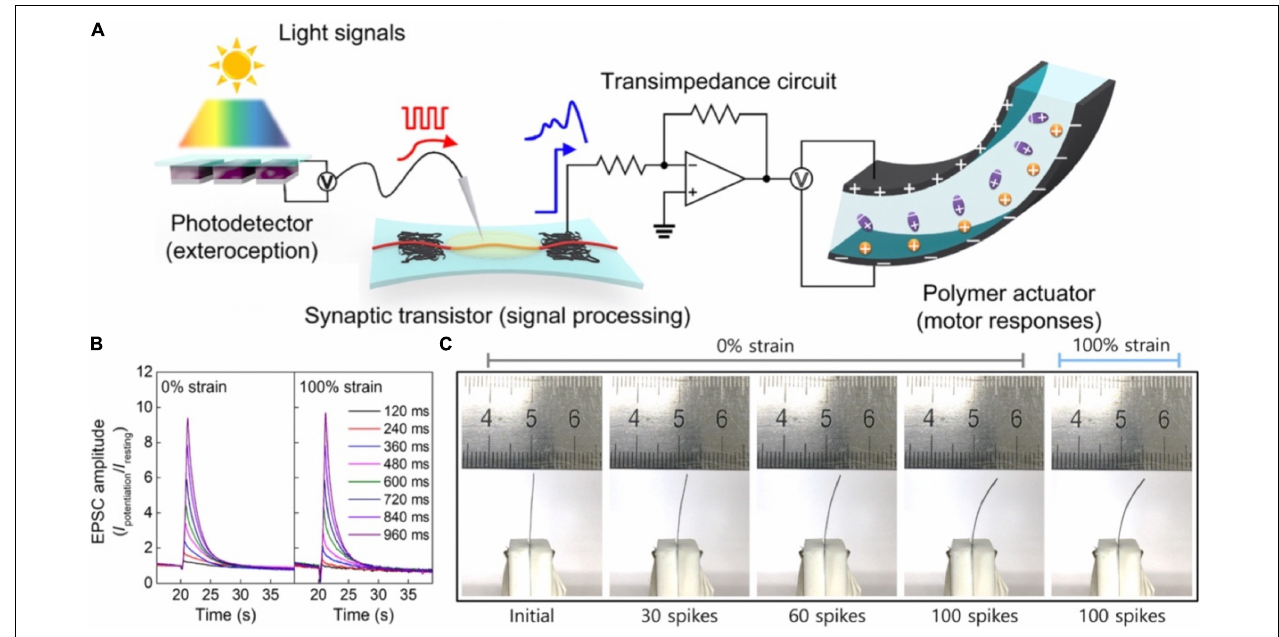
FIGURE 21 | (A) The structure diagram of artificial sensorimotor nervous system. (B) SDDP from 120 to 960 ms under 0 and 100% strains. (C) Digital images of polymer actuator controlled by various spikes with 0 or 100% strain (adapted from Lee et al., 2018).